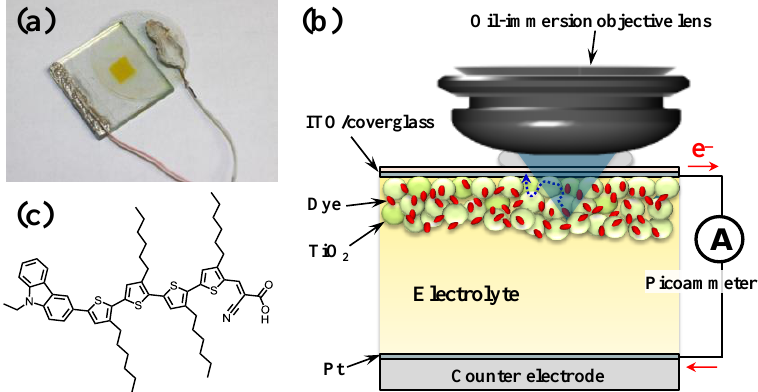
Figure 1. ( a ) Photograph of a dye-sensitized solar cell (DSSC) device with a cover glass photoanode fabricated for laser scanning microscopy (LSM) measurements. ( b ) Schematic of submicrometric LSM setup equipped with an oil-immersion objective lens. ( c ) Molecular structure of the MK-2 dye.